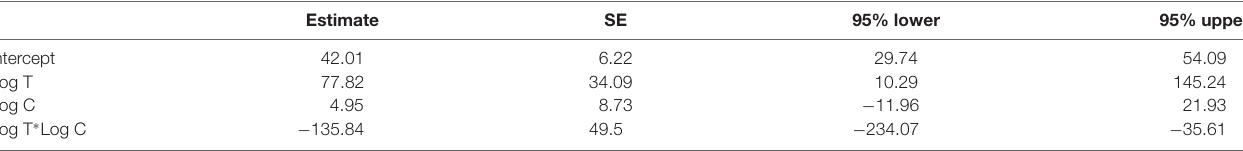
TABLE 3 | Parameter estimates, standard errors and 95%CI for T ∗ C interaction model.